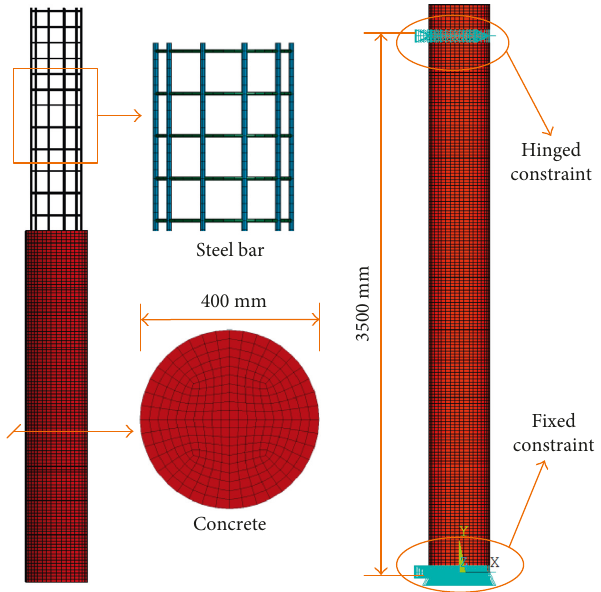
Figure 8: Finite element model of an RC